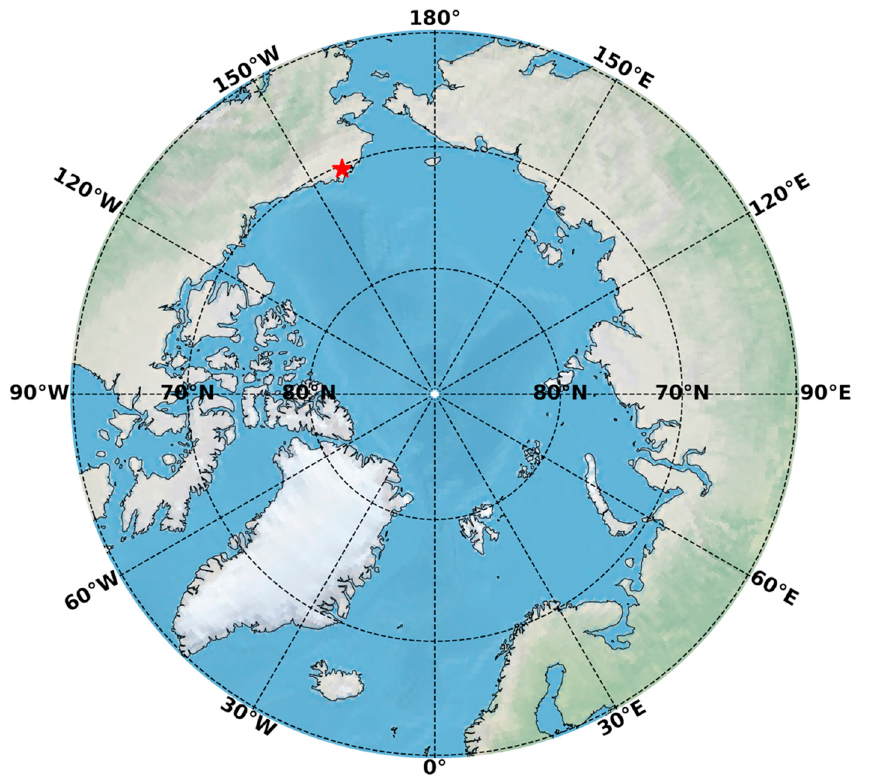
Figure 1. Geolocation of the DOE ARM NSA atmospheric observatory at Utqia ġ vik (red star). HSRL provides separated measurements of molecular and particle signals by taking the advantage of distinct observed Doppler frequency shifts of scattered light caused by molecular velocities and particle motions [43]. Particulate backscatter coefficient ( β p ) can be absolutely calibrated by reference to the molecular scattering. The molecular scattering profile at a given wavelength of the incident light can be calculated from temperature and pressure profiles measured using SONDE. ARM HSRLs use a narrow field of view receiver of 45 microradians and a narrow optical filter bandwidth of 6 GHz, which effectively reduce the background noise due to scattered sunlight [44]. After careful calibrations, ARM HSRLs provide continuous profiles of β p , lidar scattering ratio ( SR ), as well as particulate linear depolarization ratio ( δ p ) at 532 nm with a vertical resolution of 30 m from near the surface to 30 km above the ground level (AGL) and with a temporal resolution of 30 s (https://www.arm.gov/capabilities/instruments/hsrl (accessed on 18 August 2022)). Since at high altitudes lidar signals are usually dominated by background noise (especially the detector noise), we only look at aerosol structures below 8 km. From just molecules ( β m ( z ) ) at a given altitude z , SR ( z ) is the ratio of the total backscatter to the backscatter: